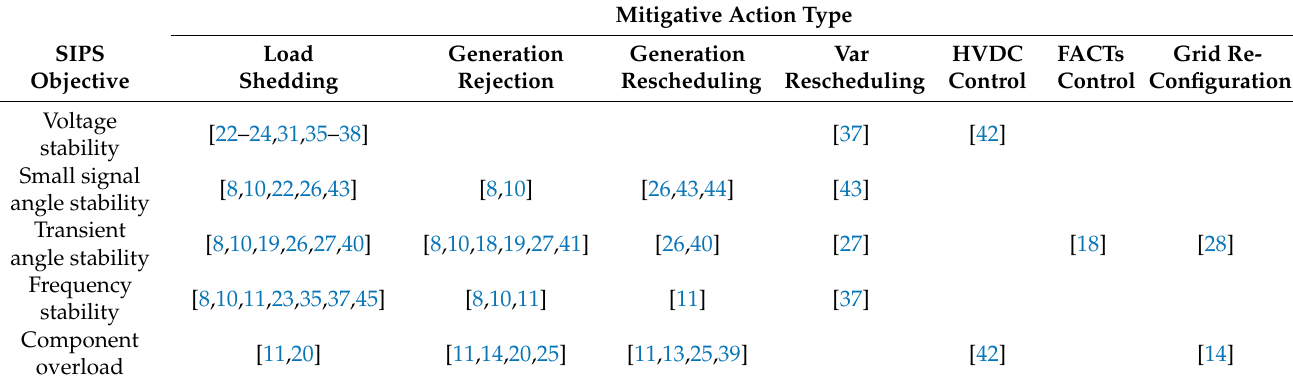
Table 2. SIPS literature classification part 1.